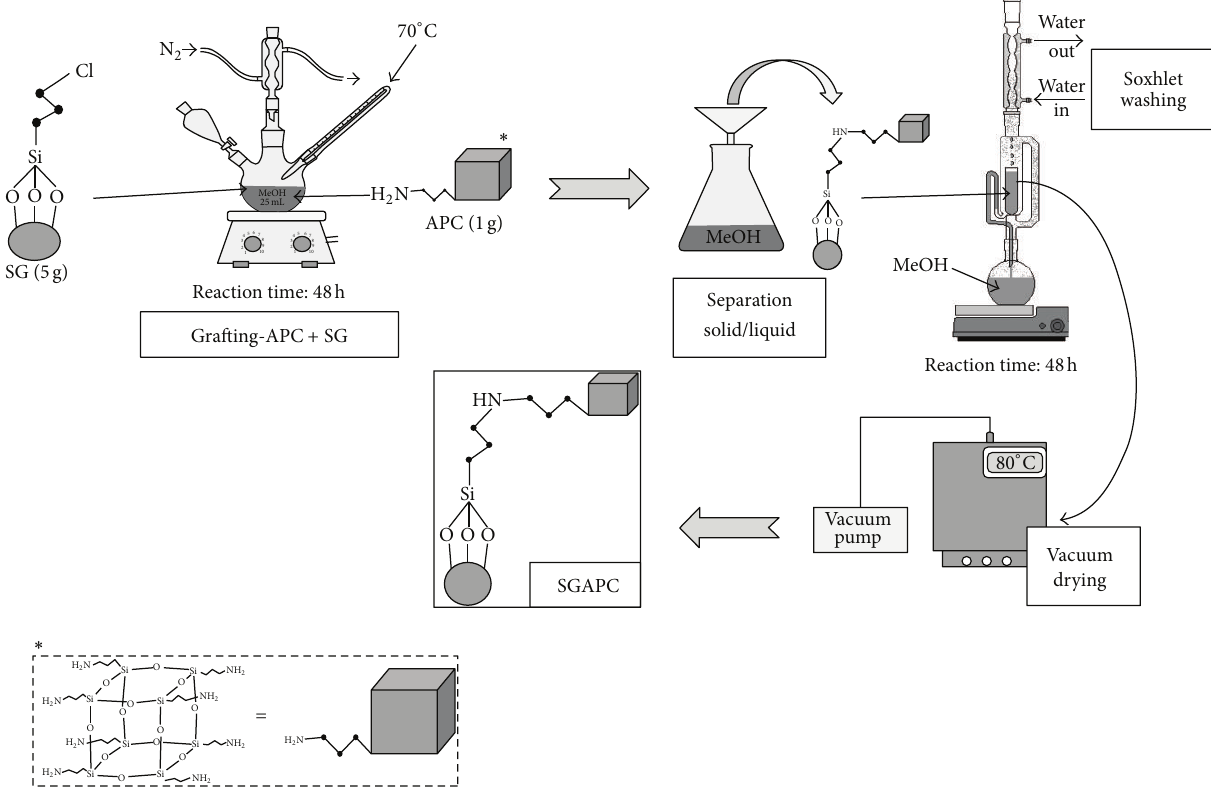
Figure 1: Schematic representation of SGAPC